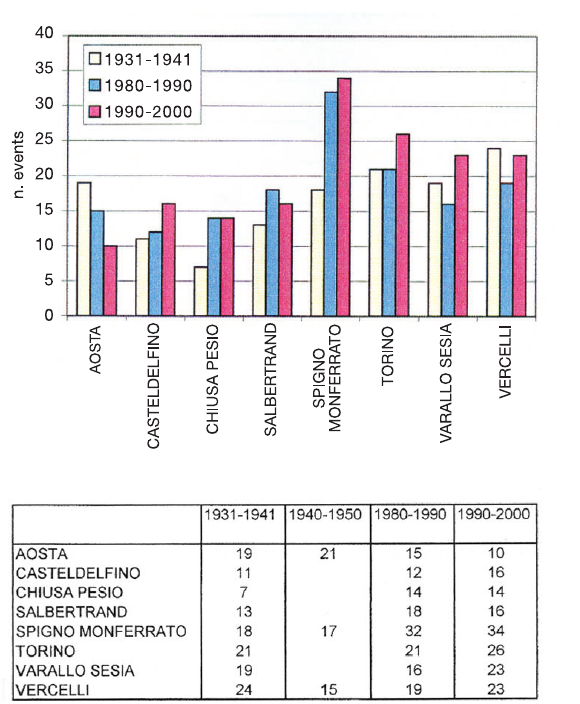
Fig. 4. Number of events of 48 h with AII different from 0.